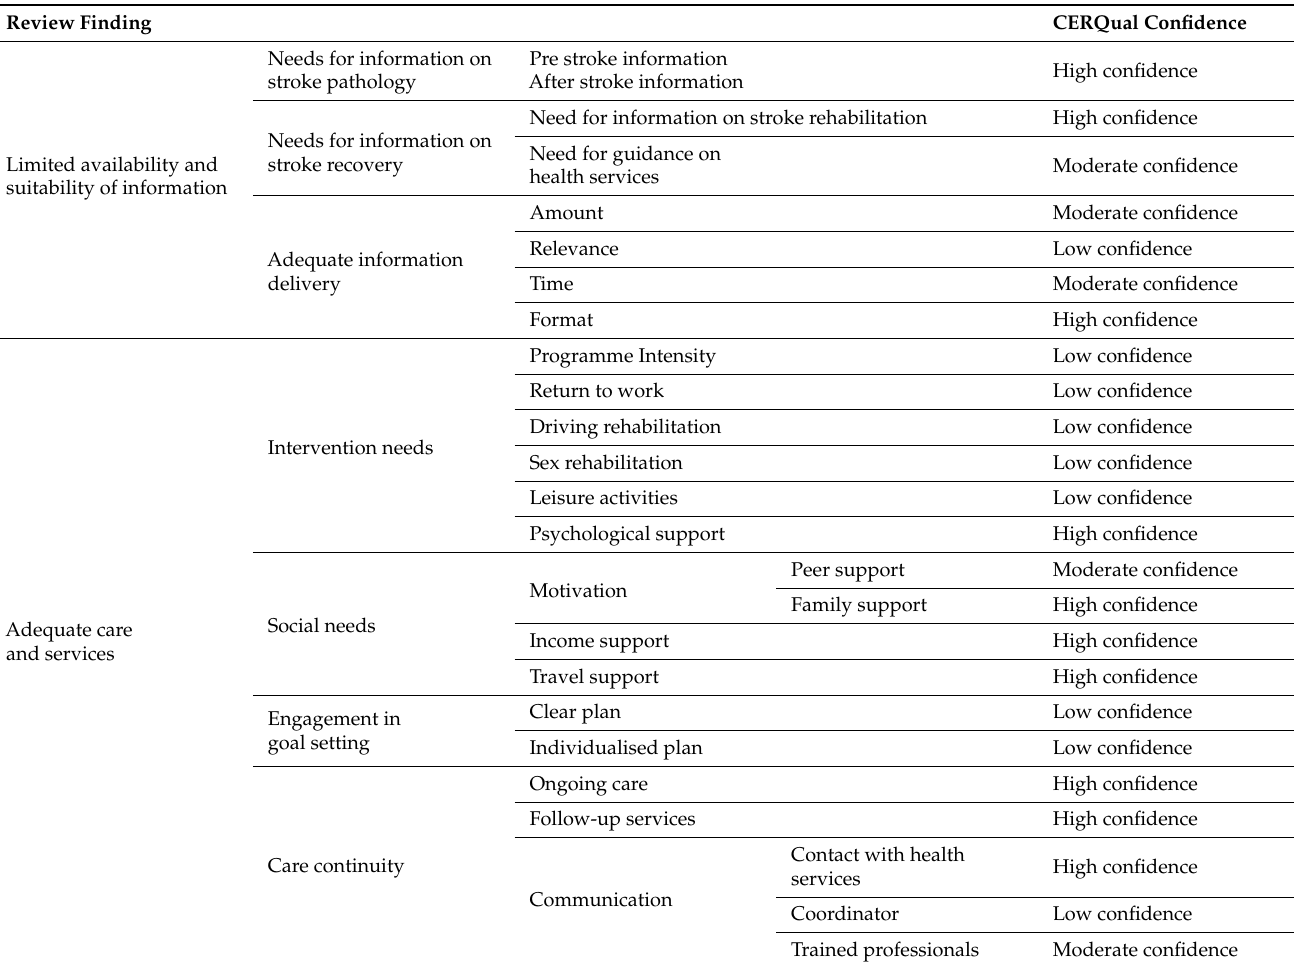
Table 2. CERQual